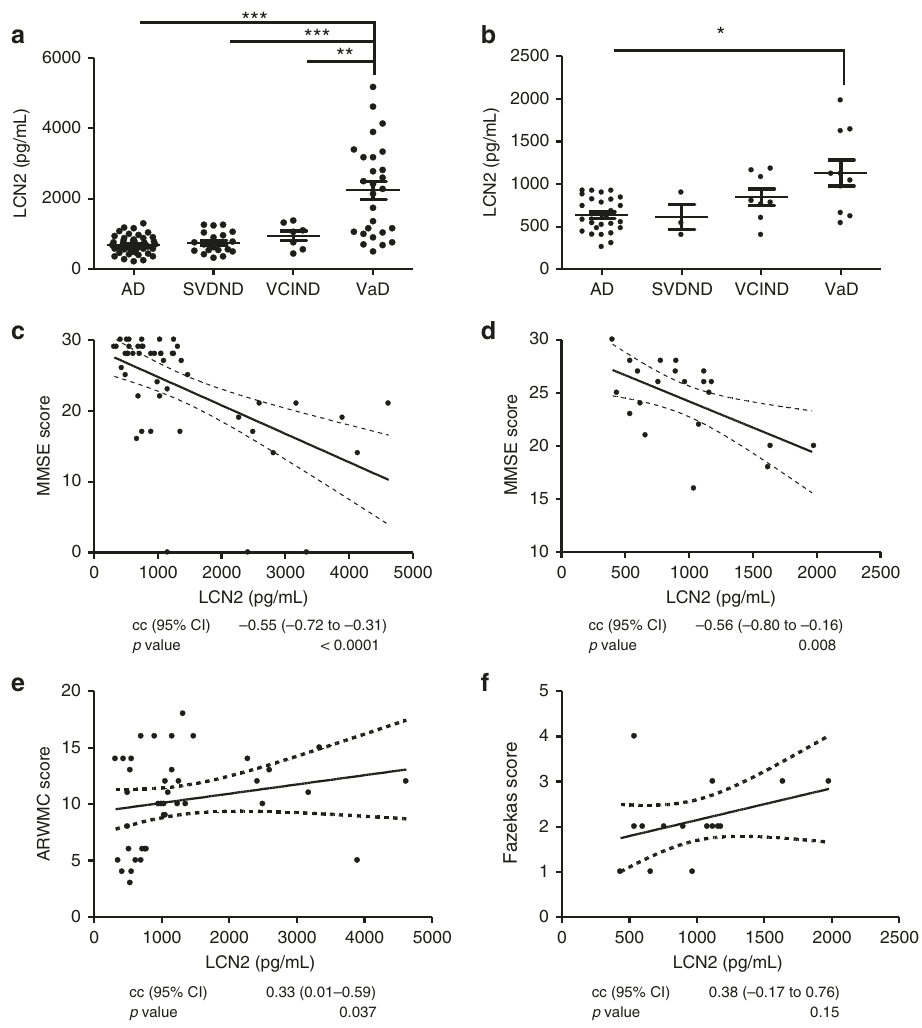
Fig. 3 Associations of CSF LCN2, cognitive status, and white matter changes (cohorts 1 and 4). a Cohort 1: LCN2 levels in Alzheimer ’ s disease (AD, n = 47), small vessel disease no dementia (SVDND, n = 20), vascular cognitive impairment no dementia (VCIND, n = 7), and vascular dementia (VaD, n = 27). b Cohort 4: LCN2 levels in AD ( n = 28), SVDND ( n = 3), VCIND ( n = 8), and VaD ( n = 10). Differences between groups were analysed with Tukey contrasts using linear regression models controlled for age and sex. * p < 0.05, ** p < 0.01, *** p < 0.001. a , b Mean± SD is represented in the graphs. c , d Correlation analysis of LCN2 and Mini Mental Status Examination (MMSE) scores in SVDND, VCIND, and VaD in cohort 1 ( n = 48) ( c ) and cohort 4 ( n = 21) ( d ). Spearman correlation test, correlation coef fi cients (cc) and associated two-tailed p values. e CSF LCN2 and age-related white matter changes (ARWMC) in SVDND, VCIND, and VaD in cohort 1 ( n = 50). Spearman correlation test, correlation coef fi cients (cc), and associated two-tailed p values. f LCN2 and Fazekas scale in SVDND, VCIND, and VaD in cohort 4 ( n = 21). Spearman correlation test, correlation coef fi cients (cc), and associated two-tailed p